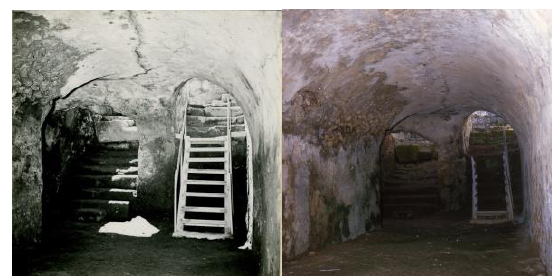
Figure 4. Plan of spherical acquisition